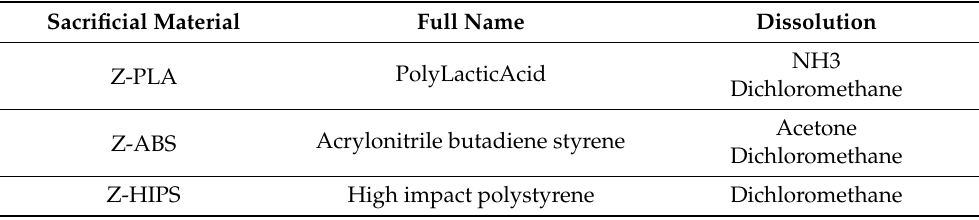
Figure 1. Design of sacrificial shapes and molds used. ( A ) A basic 0.8 mm grid placed in the dedicated mold. ( B ) Two different perfusion channels with their molds. The extremities of the channels were placed in the large notches, whereas the needles were placed inside the three small incisions. The needles were localized 500 µm above the perfusion channel. Table 1. Sacrificial material tested and their associated